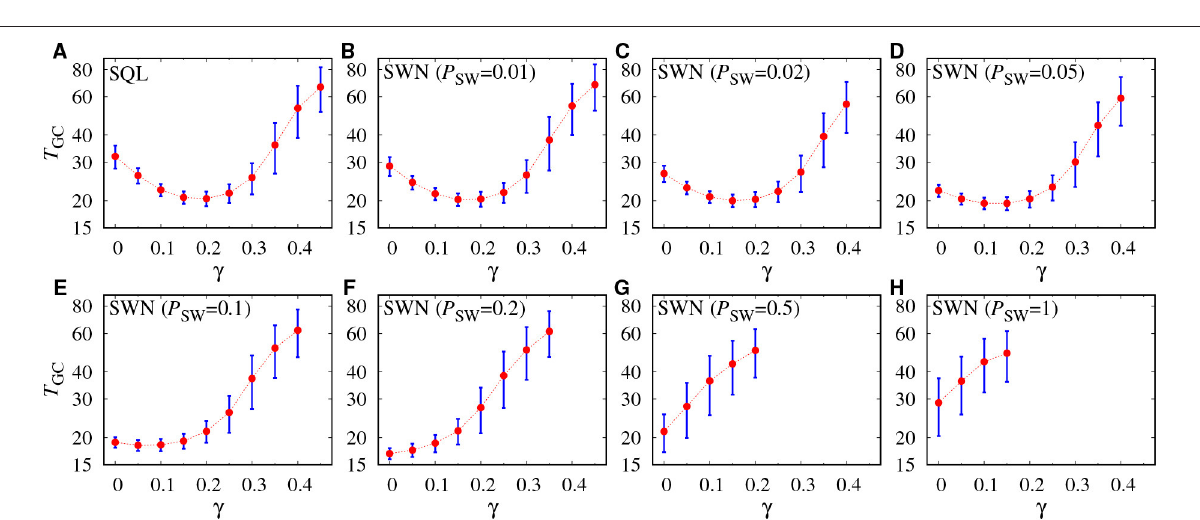
FIGURE 4 | Time to global cascades ( T GC ) as a function of γ for the SQL (A) and SWNs (B–H) with various rewiring probability P SW . Note that the vertical bars at every symbol represent a standard deviation of T GC , not a statistical error. Error bars for the statistical error are smaller than the symbol